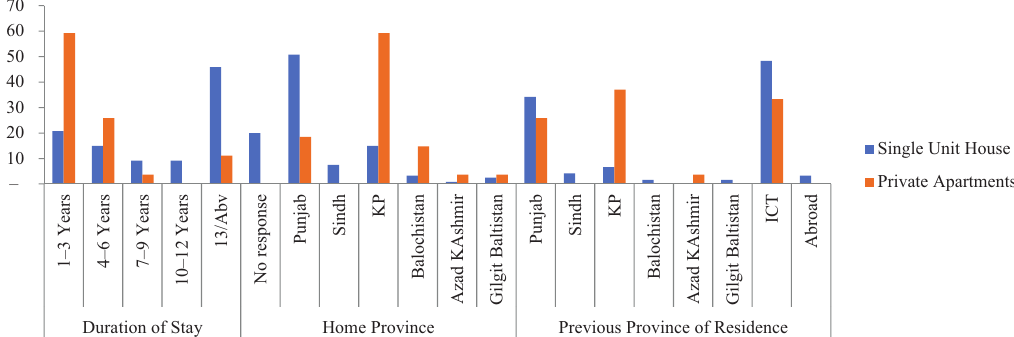
Figure 5. Ownership and physical features of S.U. houses and apartments (source: field survey)